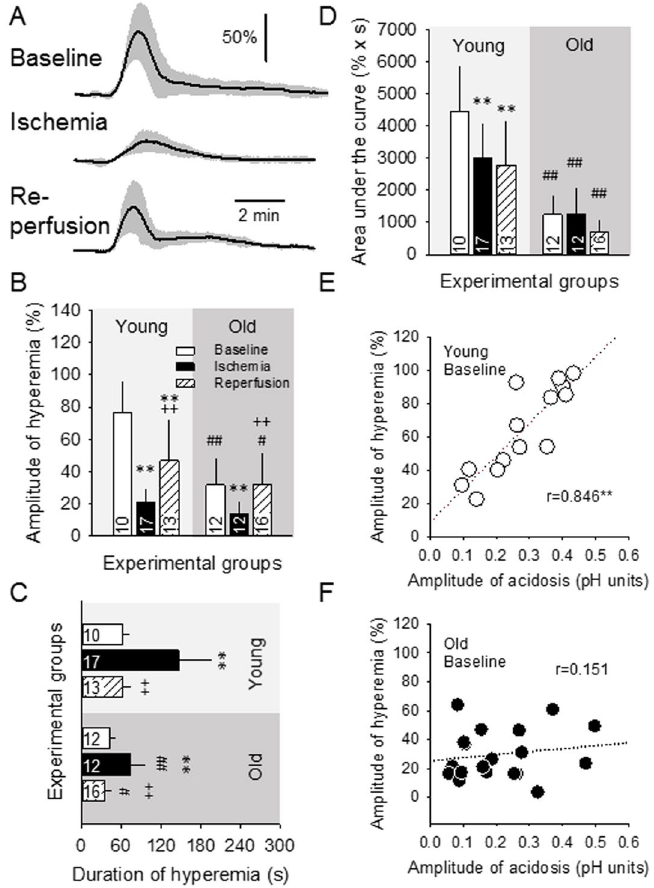
Figure 4. The impact of age and the association of tissue pH with the cerebral blood flow (CBF) response to spreading depolarization (SD). All data were obtained with laser Doppler flowmetry and pH sensitive microelectrodes (the latter applicable for panels E and F). ( A ) CBF variations associated with SDs, occurring in subsequent phases (i.e. baseline, ischemia, reperfusion) of the experiments in young rats. Each trace is the average of individual ones taken from separate experiments, and are presented as mean ± stdev (n = 6/8). ( B ) Relative amplitude of hyperemia. ( C ) Duration of hyperemia at half amplitude. ( D ) Magnitude of hyperemia expressed as area under the curve. ( E ) The relative amplitude of SD-related tissue acidosis and hyperemia show a direct, linear, positive correlation in the intact cortex of young rats. ( F ) The above correlation is lost in the intact cortex of old animals. Data in the bar charts are given as mean ± stdev, sample size (number of events) is shown in each bar. For the evaluation of statistical significance, a two-way analysis of variance (ANOVA) paradigm considering age and the phase of the experiment as its factors was applied. Level of significance for the ANOVA was defined as * p < 0.05 and ** p < 0.01. Significant differences between groups were determined by a Fisher post hoc test as follows: * p < 0.05 and ** p < 0.01, vs. respective Baseline; + p < 0.05 and ++ p < 0.01, vs. respective Ischemia; # p < 0.05 and ## p < 0.01, vs. respective Young. Normality of data in E and F was tested by the Shapiro-Wilk test (Young acidosis p = 0.293, Young hyperemia p = 0.155, Old acidosis p = 0.051, Old hyperemia p = 0.151), followed by Spearman correlation analysis ( ** p <